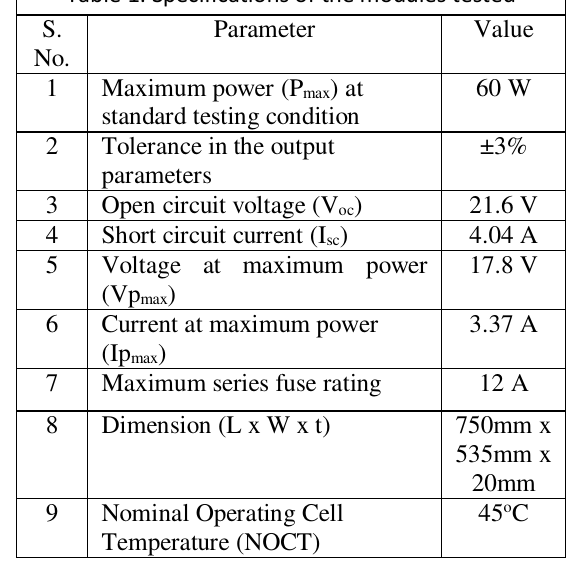
Table 1: Specifications of the modules tested